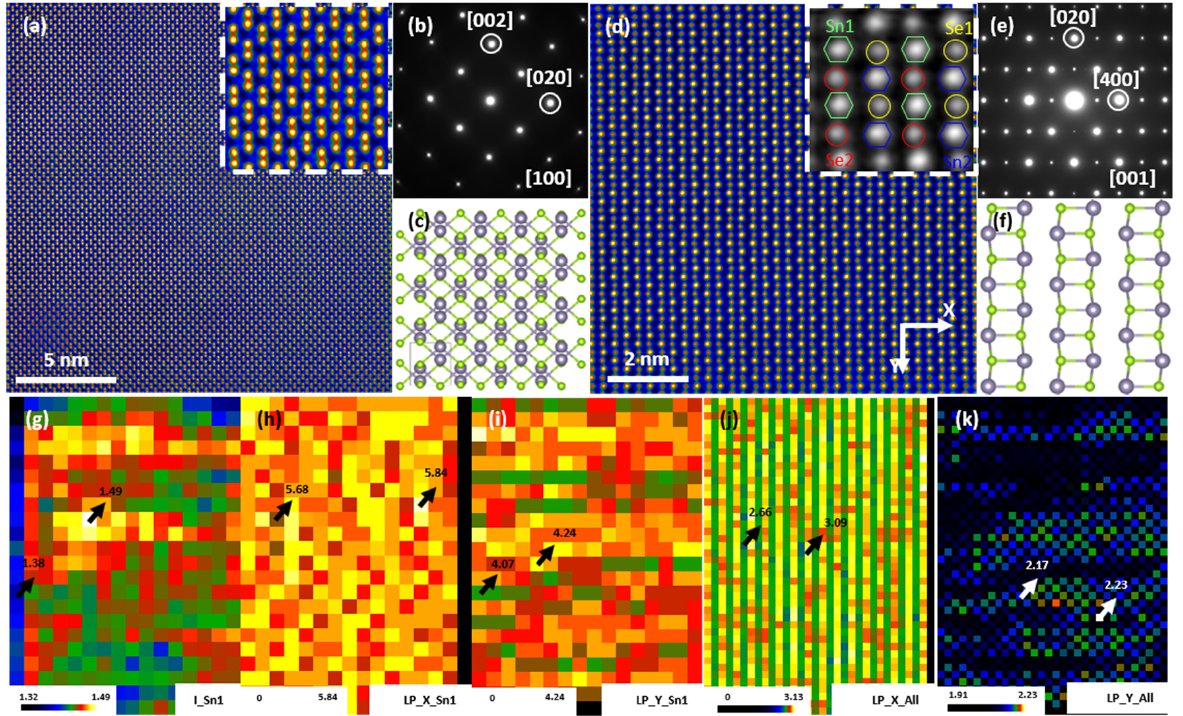
Figure 9. Substitutions in Te-alloyed SnSe crystals. ( a ) Atomically-resolved STEM HAADF image along {100} region axis, embedded with magnified images. ( b , c ) Electron diffraction pattern and structural model along {100} zone axis. ( d ) Atomically-resolved STEM HAADF image along {001} region axis, embedded with magnified images. The four types of atomic columns are labeled Sn1, Sn2, Se1 and Se2. ( e , f ) Electron diffraction pattern and structural model along {001} axis. ( g – j ) Intensity and lattice parameter distribution of different types of atom columns obtained from ( d ), where the lattice parameters unit is Å and intensity values are relative. ( g ) Intensity mapping of Sn1 atom columns. ( h ) Lattice parameters (LP) of Sn1 atom columns along X direction. ( i ) Lattice parameters of Sn1 atom columns along Y direction. ( j , k ) Lattice parameters of all the atom columns along X and Y directions. Reproduced from Ref. [33] Copyright 2019 American Chemical Society.